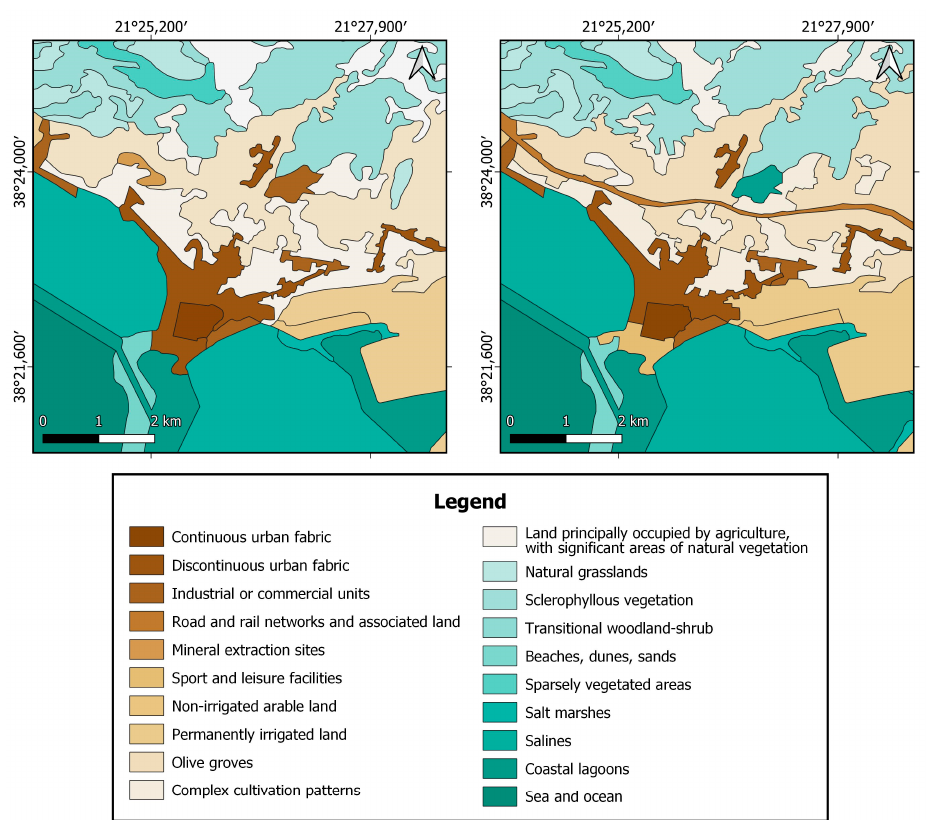
Figure 14. Land use for the greater area of Messolonghi in ( a ) 2006 and in ( b ) 2018.